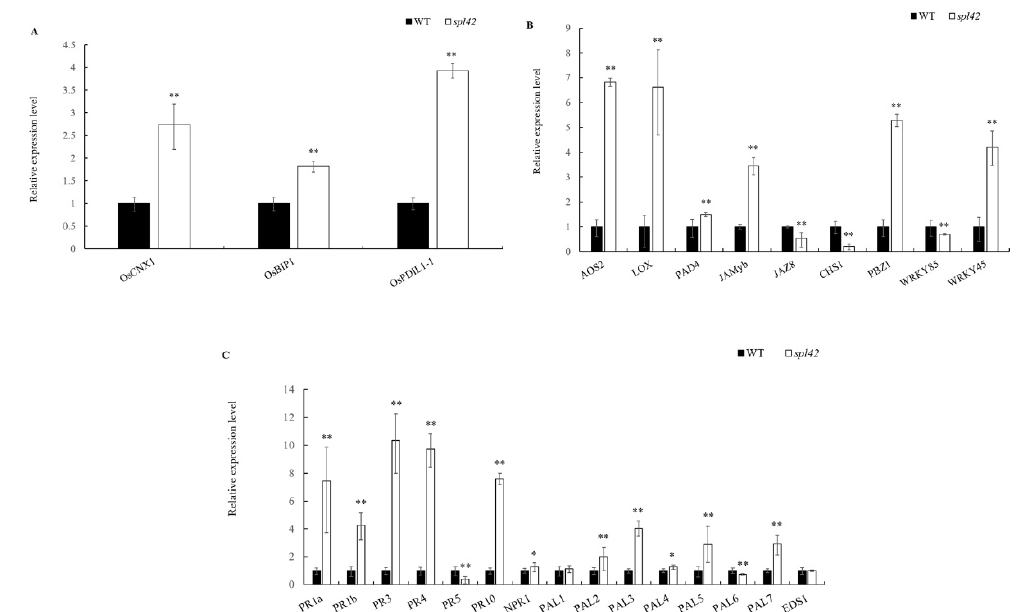
Figure 4. Expression analysis of defense-related gene families in wild type (WT) and spl42 . ( A ) Endoplasmic reticulum chaperone gene qRT-PCR analysis. ( B ) qRT-PCR analysis of JA signaling genes. ( C ) qRT-PCR analysis of SA signaling genes. Error bars represent ± SD ( n = 3). Asterisks indicate a significant difference between the WT and spl42 plants by Student’s t -test, ** p < 0.01; * p < 0.05.